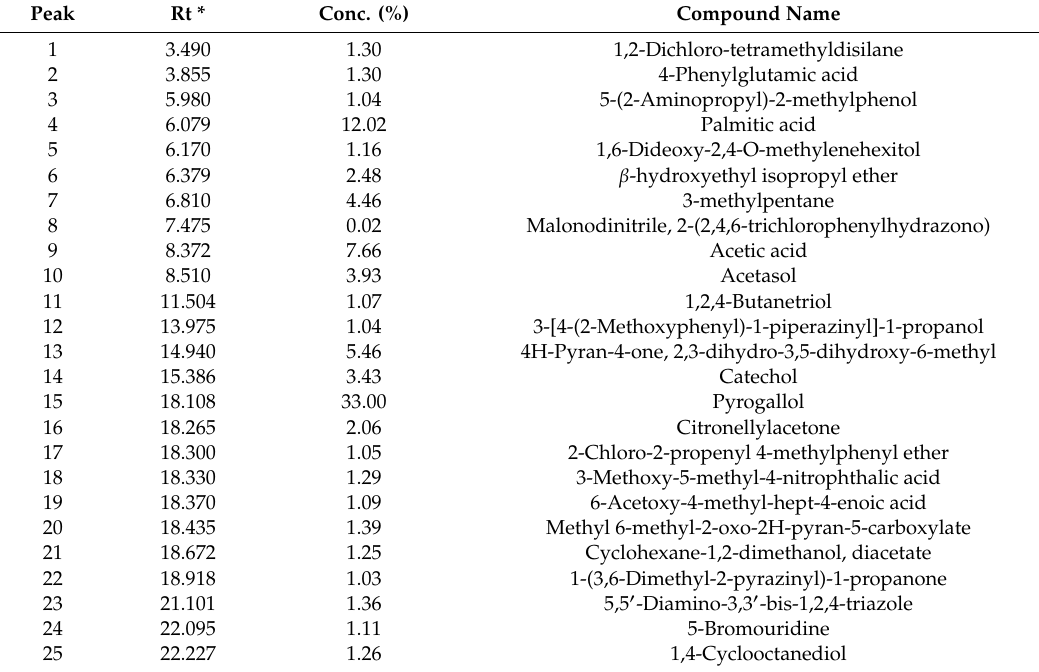
Table 4. Chemical composition of C. polygonoides root extract as detected by GC-MS system.